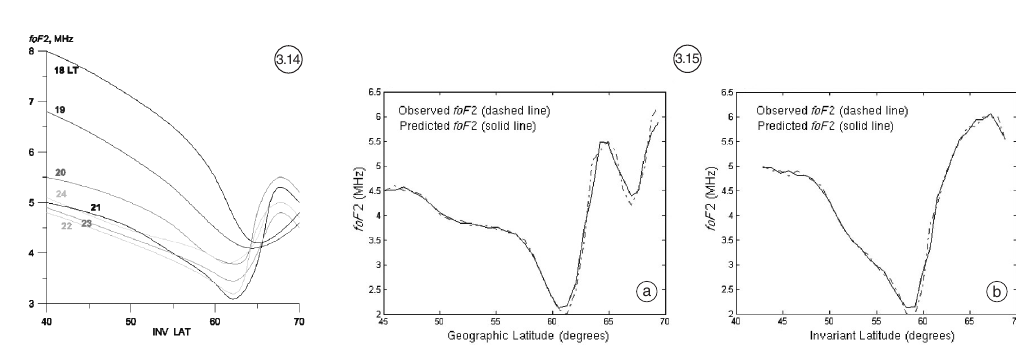
Fig. 3.14. An illustration of the range of positions and shapes of the mid-latitude trough, showing the invariant magnetic latitudinal variation of the averaged foF 2 values at various fixed local times, for the data in the peri- ods listed in table 3.III. Fig. 3.15a,b. The predicted foF 2 position and shape of the mid-latitude trough, from data and as modelled by the METU-NN neural network model. a) METU-NN predicted foF 2 values against geographic latitude, with longitude 55°E, local time 02:42 and Kp = 2. b) METU-NN predicted foF 2 values against invariant latitude, with longitude 10°E, local time 03:00 and Kp =